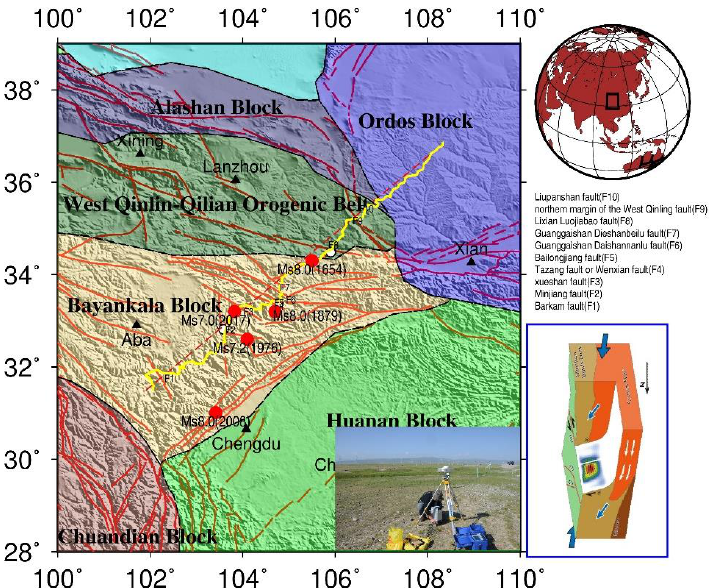
Figure 1. Distribution of gravity/GPS stations and fault in the Ms7.0 earthquake area in Jiuzhaigou, Sichuan Province. The yellow points represent the distribution of gravity and GPS stations; the red lines represent faults [19]; the white circles represent absolute gravity station; the black triangles represent place name; the red circles represent the epicenters of Ms7.0 or larger earthquake in the area, data from China Earthquake Networks Center; the photo in this figure is a field